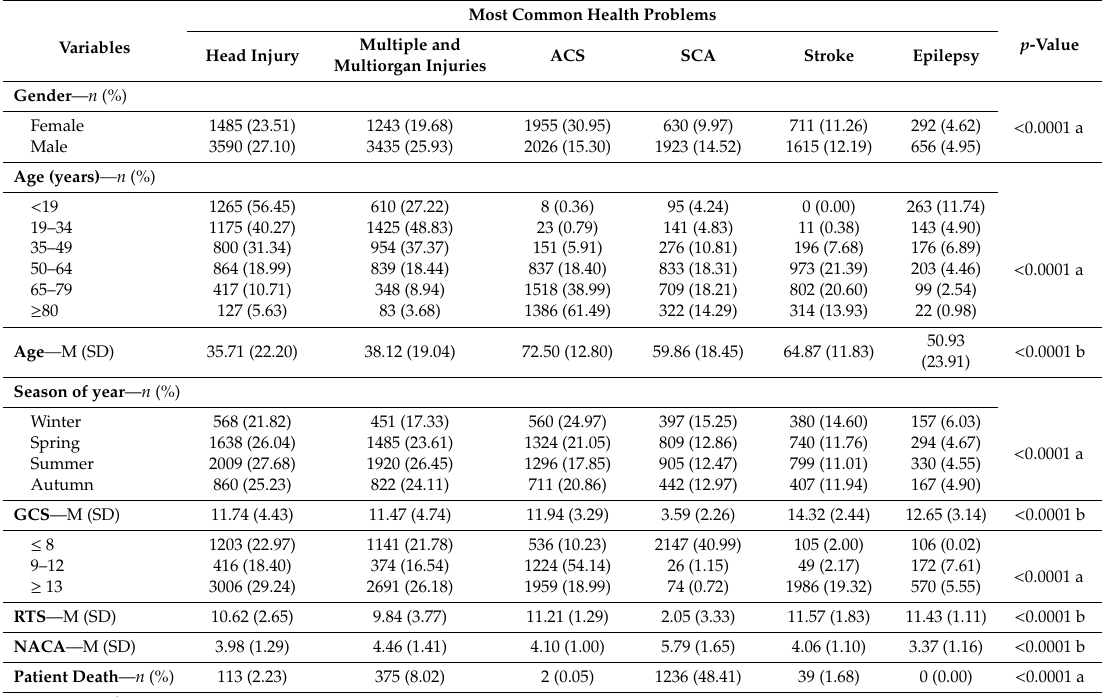
Table 4. Statistical analysis of most common diseases in correlation with patient characteristics and clinical